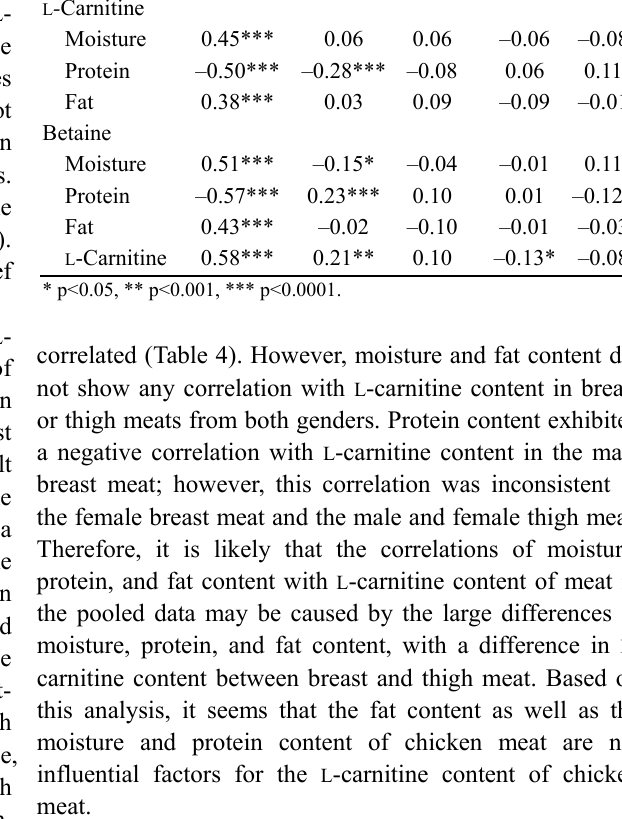
Table 5. Betaine content (mg/100 g) of breast and thigh meat from Korean native chicken breeds